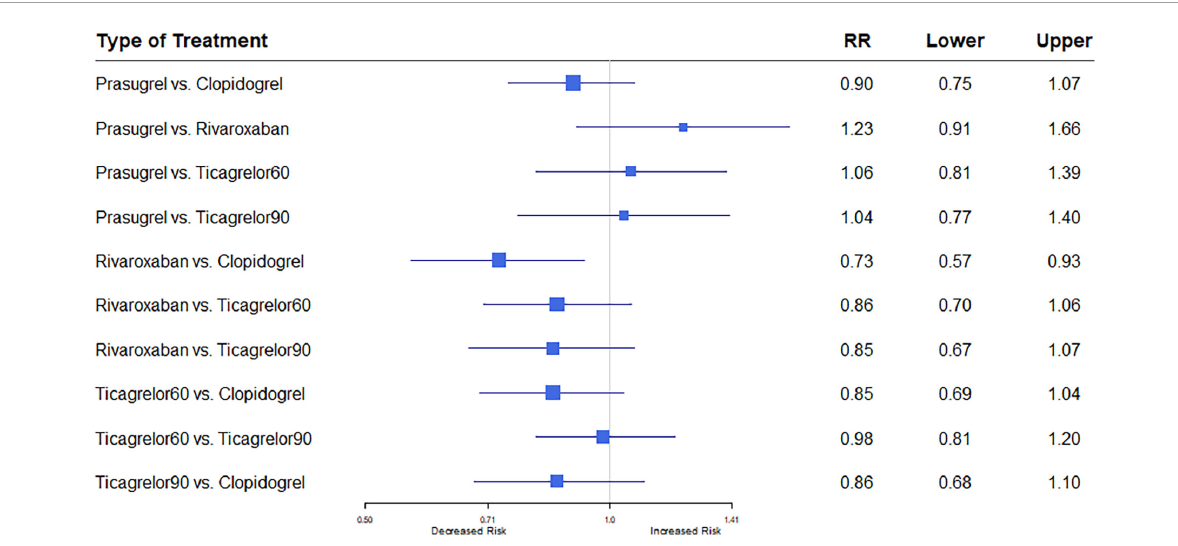
FIGURE3 A network meta-analysis of the association between anti-thrombotic therapy and major adverse cardiac events (MACE) in patients with chronic coronary syndrome. Net-work Meta-analysis of the Association Between anti-thrombotic therapy and mortality. The size of squares is proportional to the weight of each study. Horizontal lines indicate the 95% CI of each treatment; diamond, the pooled estimate with 95% CI; and RR, relative risk.